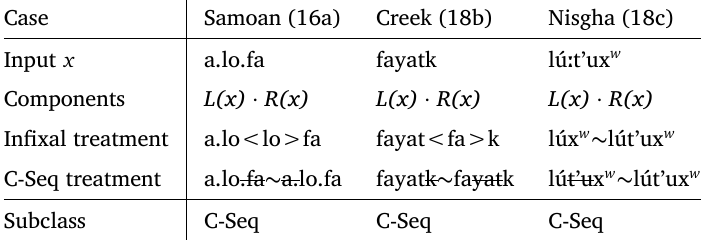
Table 8: Non-C-OSL patterns of internal or non-contiguous